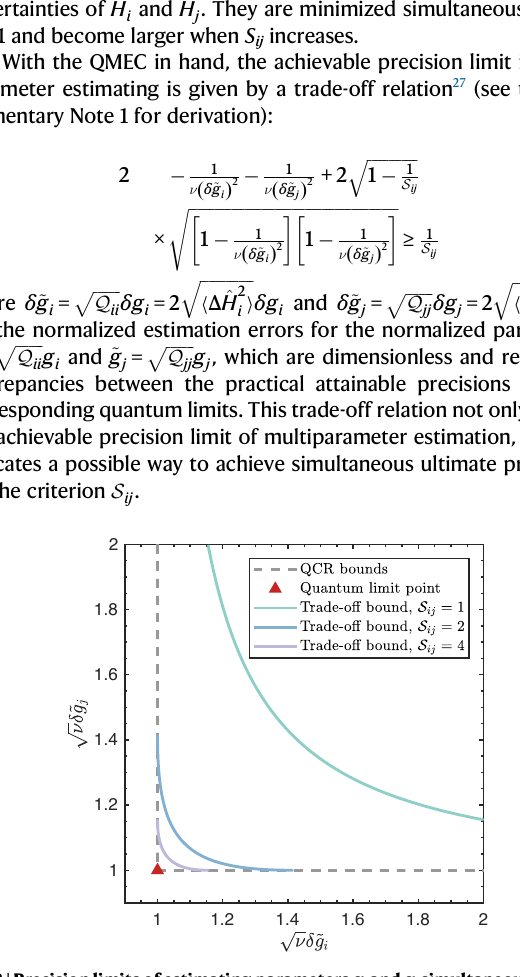
Fig.2|Precisionlimitsofestimatingparameters g i and g j simultaneously. The x axisand y axisareseparatelythenormalizedestimationerrorsofparameters g i and g j . The gray dashed lines are separately the QCR bounds for parameters g i and g j , which are directly obtained from their corresponding QFI. The cross point (red triangle in fi gure) of gray dashed lines is the quantum limit point where both parametersachievethetheoreticalultimateprecision.Thegreensolidcurvestands forthetrade-offboundofparameters g i and g j with S ij =1,whichcorrespondstothe minimum-uncertainty probe state. The blue and purplesolid curves are separately the trade-off bounds with S ij =2 and S ij